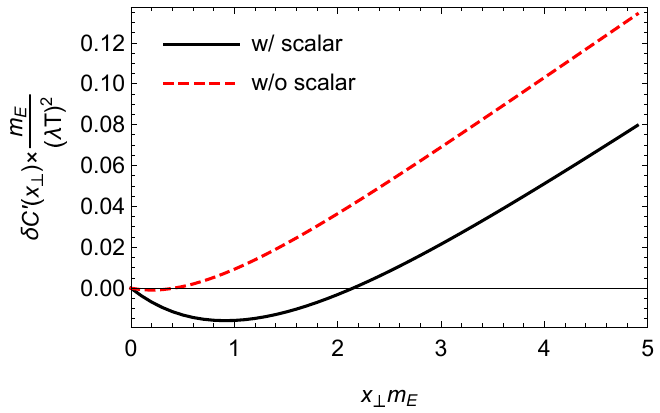
′ ( x Figure 6 . δ m E / ( λT ) 2 as a function of x ⊥ m E . The solid black line is eq. (3.10), while ⊥ ) C × the dashed red line is the QCD contribution only, without the scalar loop